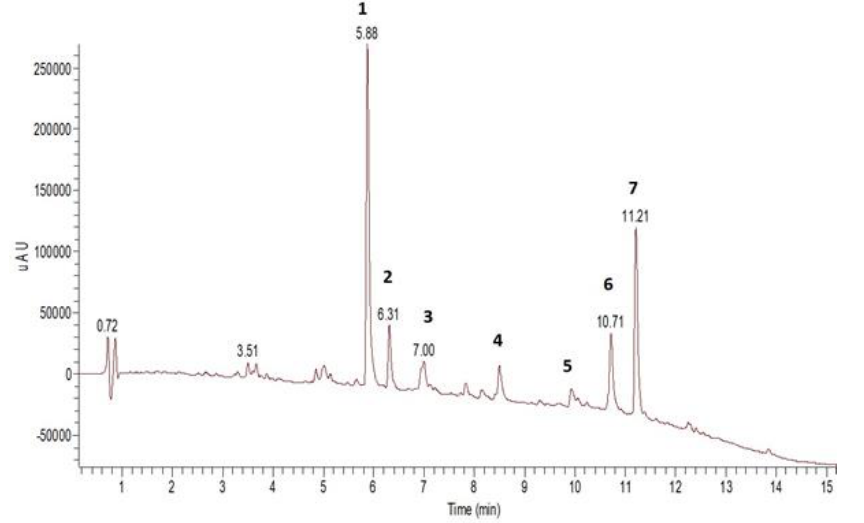
Figure 1. UHPLC separation of Satureja montana ethanolic extract. Total scan UV chromatogram (190-500 nm). Peak assignments: 1 = rosmarinic acid, 2 = caffeoyl rosmarinic acid isomer, 3 = apigeninmethyl ether hexosyldeoxyhexoside, 4 = trihydroxy-trimethoxyflavone, 5 = dihydroxy-dimethoxyflavone, 6 = thymoquinone, 7 = carvacrol.